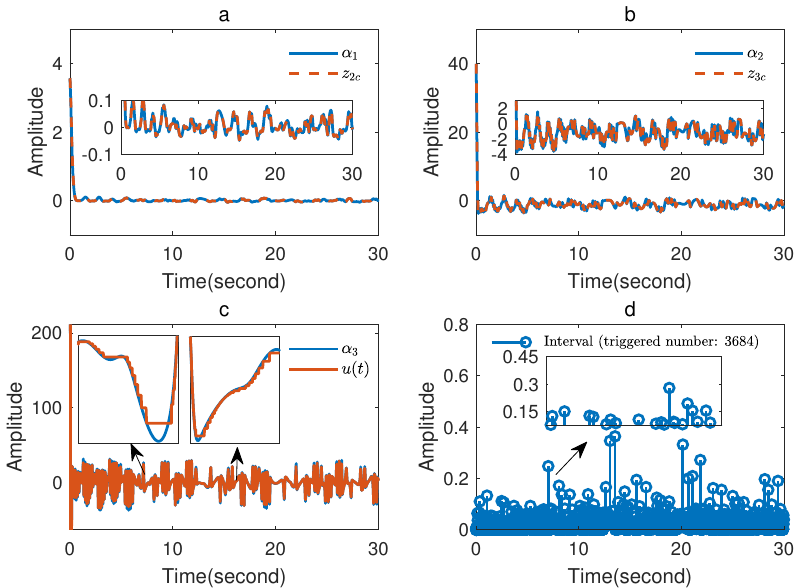
Figure 4. Simulation results. ( a ) Virtual control α 1 and command filter output z 2 c . ( b ) Virtual control α 2 and command filter output z 3 c . ( c ) Curves of controller α 3 and u ( t ) . ( d ) The event-triggered responses of controller u ( t )